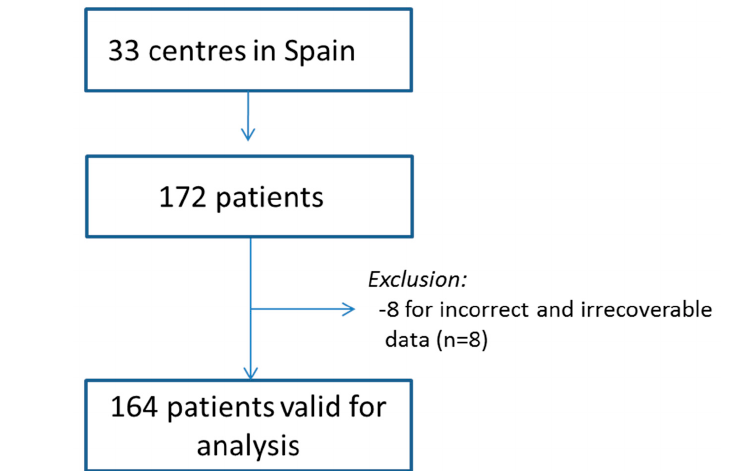
Figure 1. Flow chart of the study. Table 1. Baseline characteristics of the